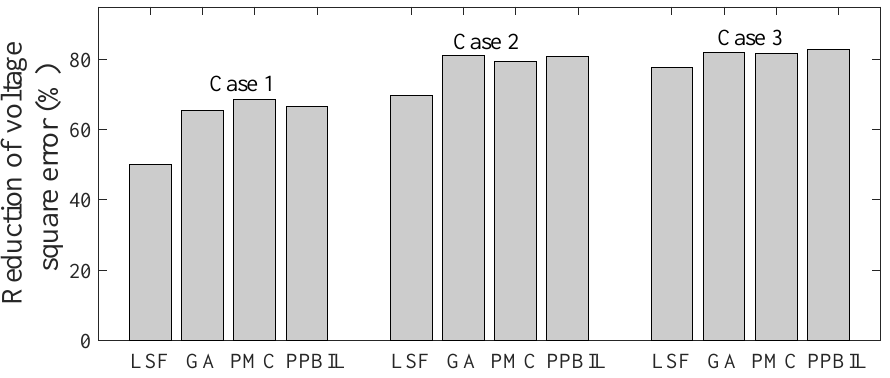
Figure 17. Reduction of voltage square error in the test system with 69 buses.